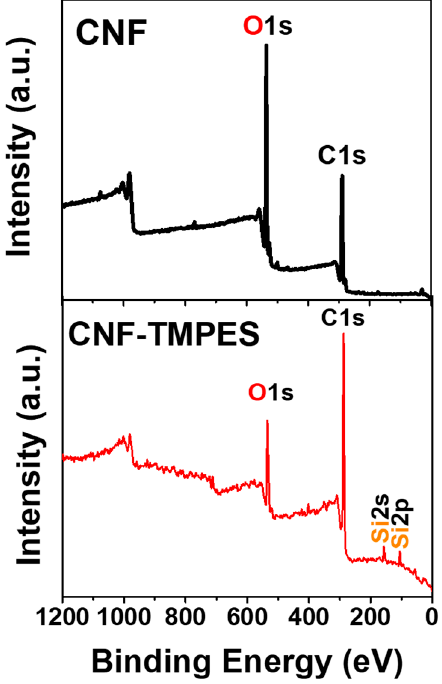
Figure 3. XPS spectra of CNFs and TMPES-modified CNFs films.